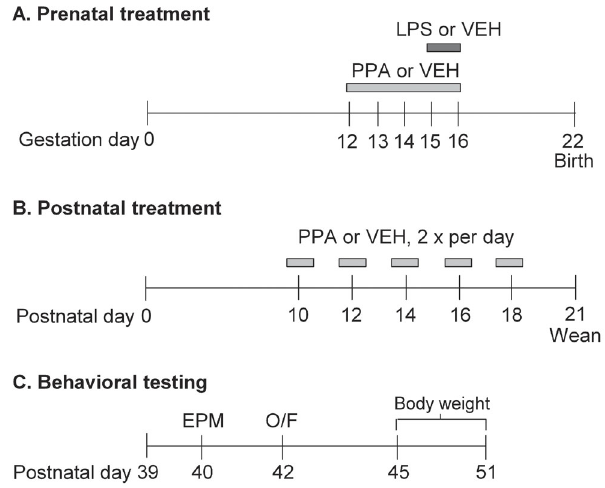
Figure 1. Study timeline. A: Prenatal treatment – Pregnant dams received propionic acid (PPA) or vehicle once a day from gestation day 12–16 to yield the prenatal PPA and 5VEH groups. Lipopolysaccharide or vehicle was administered once a day on gestation days 15 and 16 to yield the prenatal LPS and 2VEH groups. B: Postnatal treatment – Half the pups in all litters received PPA every second day (2 times a day) from P10–18 with the other half receiving vehicle. C: Behavioral testing in adolescence – EPM: elevated plus maze; O/F: open-field activity and thigmotaxis; behavioral data collected from P45–51 reported elsewhere.